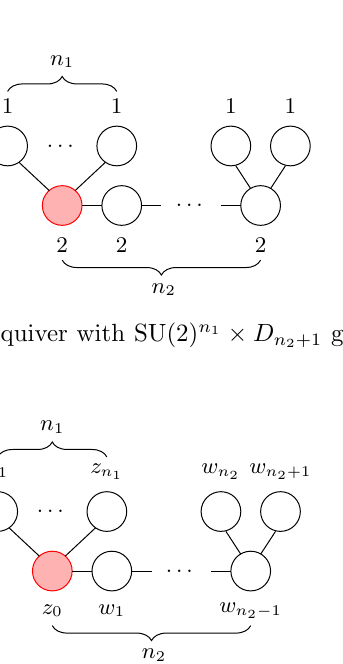
( n 1 ), P (2) g quiver with fugacity [1 n 1 ] [1 2 ]